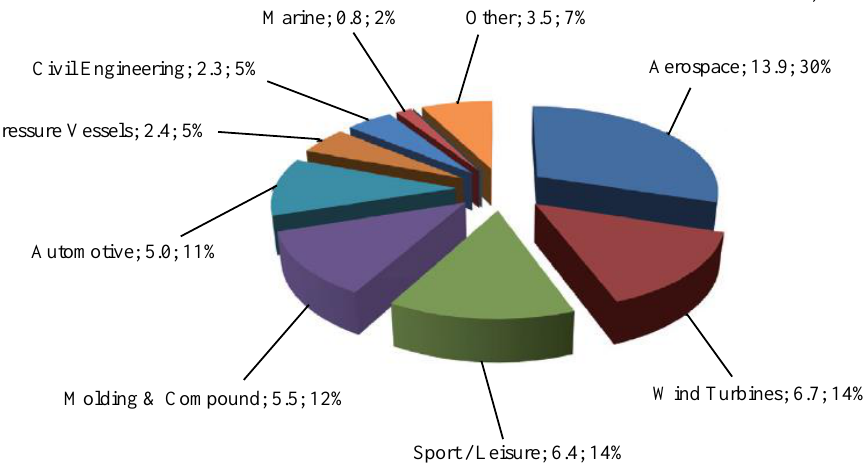
Figure 1. Carbon fiber global demand in the year 2013 (adapted with permission from Ref. [10]).